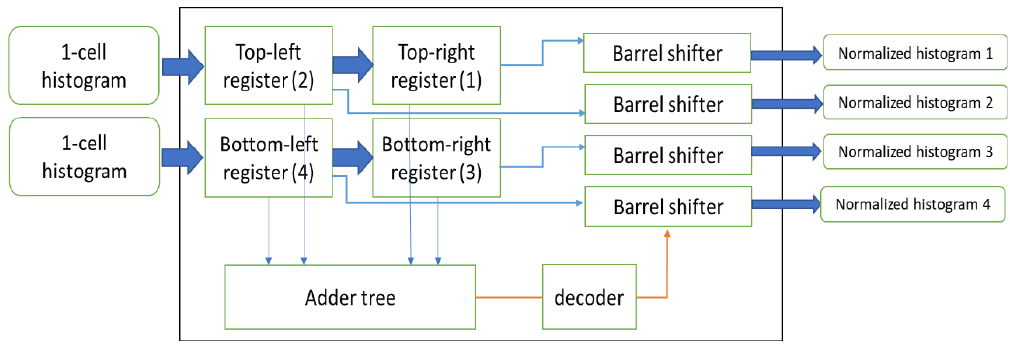
Figure 13. The block diagram of block normalization module.